Question: Is the quantity shown trending increasing or decreasing?
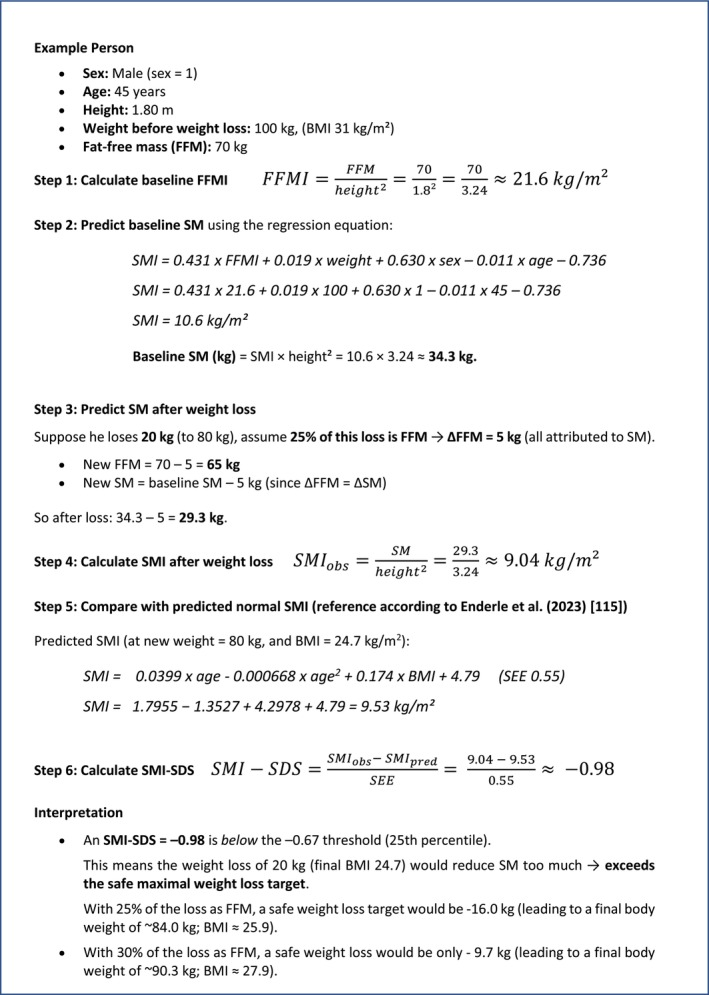
Answer: decreasing